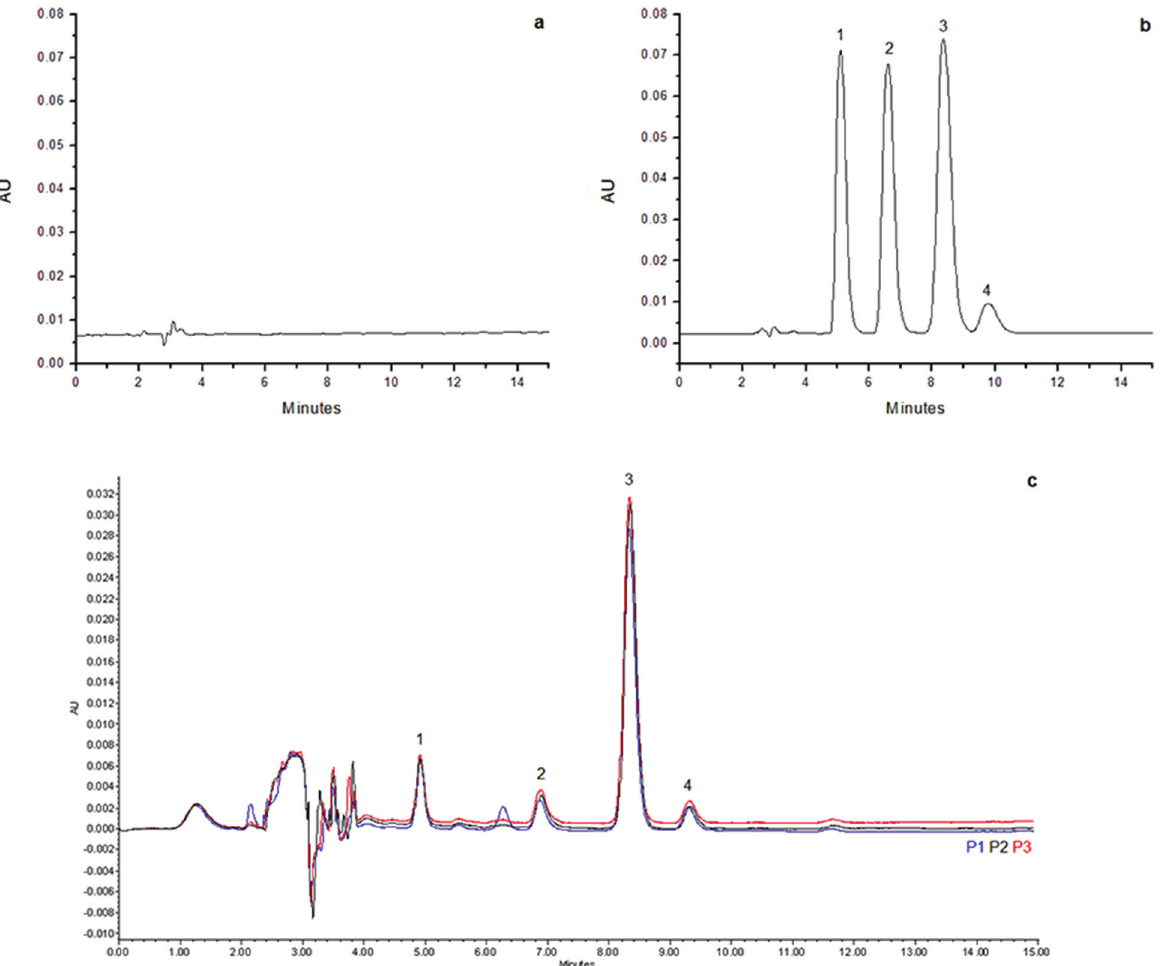
Figure 1 - ( a ) Chromatogram of preserved area soil sample used as a reference. ( b ) Chromatogram of analytical standards mixture at an individual concentration of 9.6 mg L -1 . ( c ) Chromatograms of three soil samples collected in a sugarcane cultivation area. Analytes: DCPU (1), DCPMU (2); diuron (3), and DCA (4). Mobile phase: water:acetonitrile (55:45 v/v); flow rate: 0.86 mL min -1 ; injection volume: 20 μL; column: XTerra C (4.6 × 250 mm, 5 μm); λ: 254 18